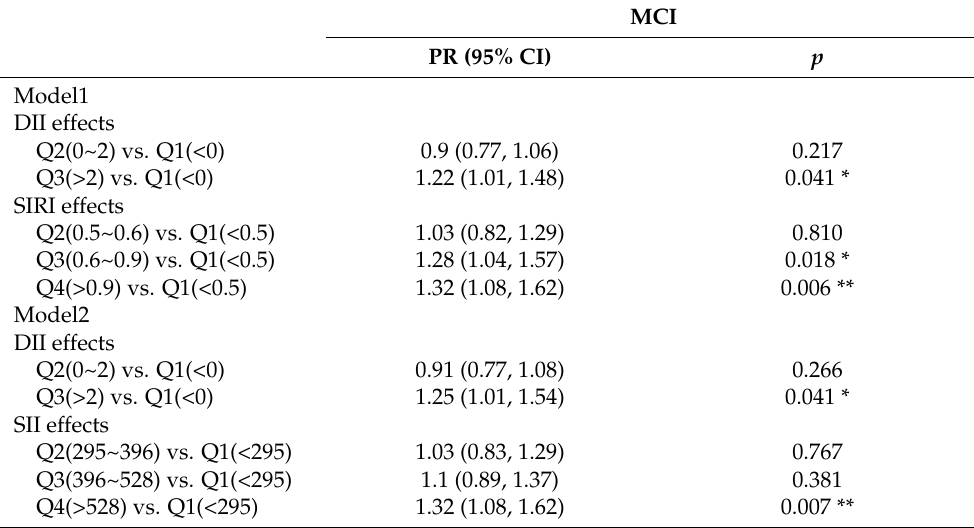
Table 7. The synergistic effects of DII with SII or SIRI on the occurrence of